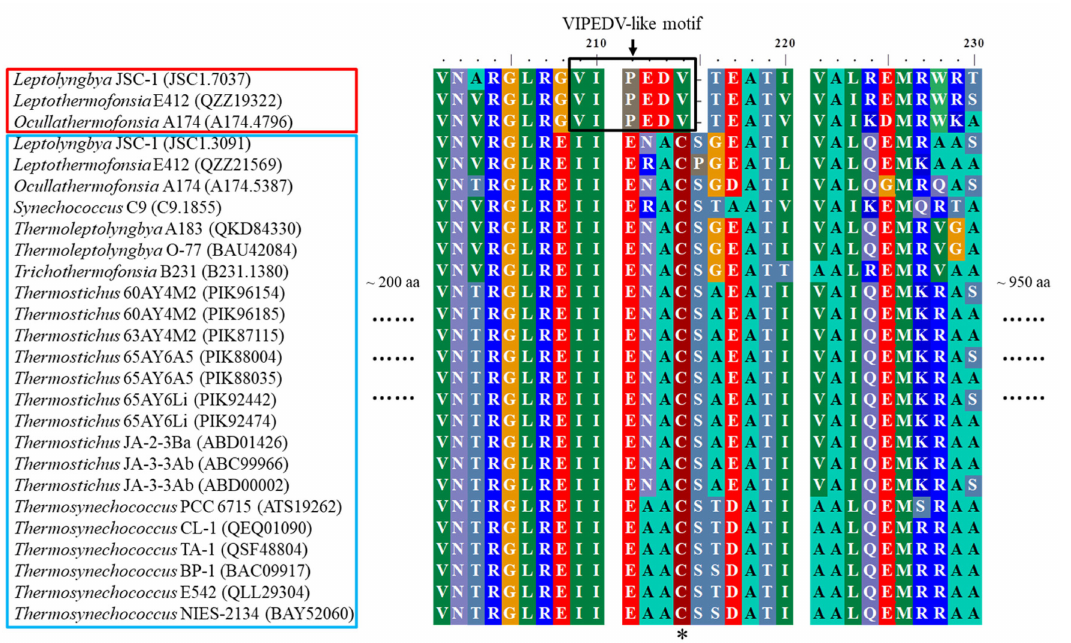
Figure 3. Conserved far-red specific-motifs present in apcE of thermophilic cyanobacteria. Ther- mophiles outlined in red contain conserved far-red-specific motifs in apcE sequences, while ther- mophiles in the blue box encompass conventional (white light) apcE sequences. The black box highlights the far-red-specific motif and the phytochrome-binding cysteine is indicated by an